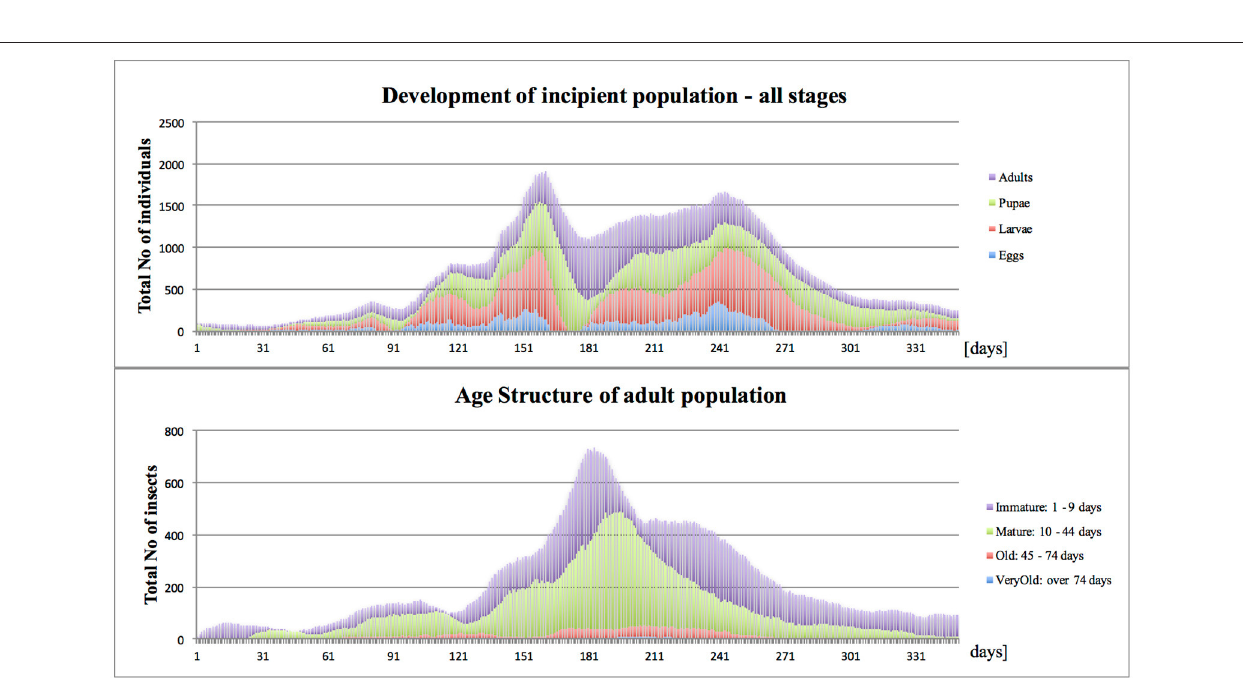
FIGURE 1 | “Virtual” model-generated landscapes of varying degree of fragmentation and complexity.